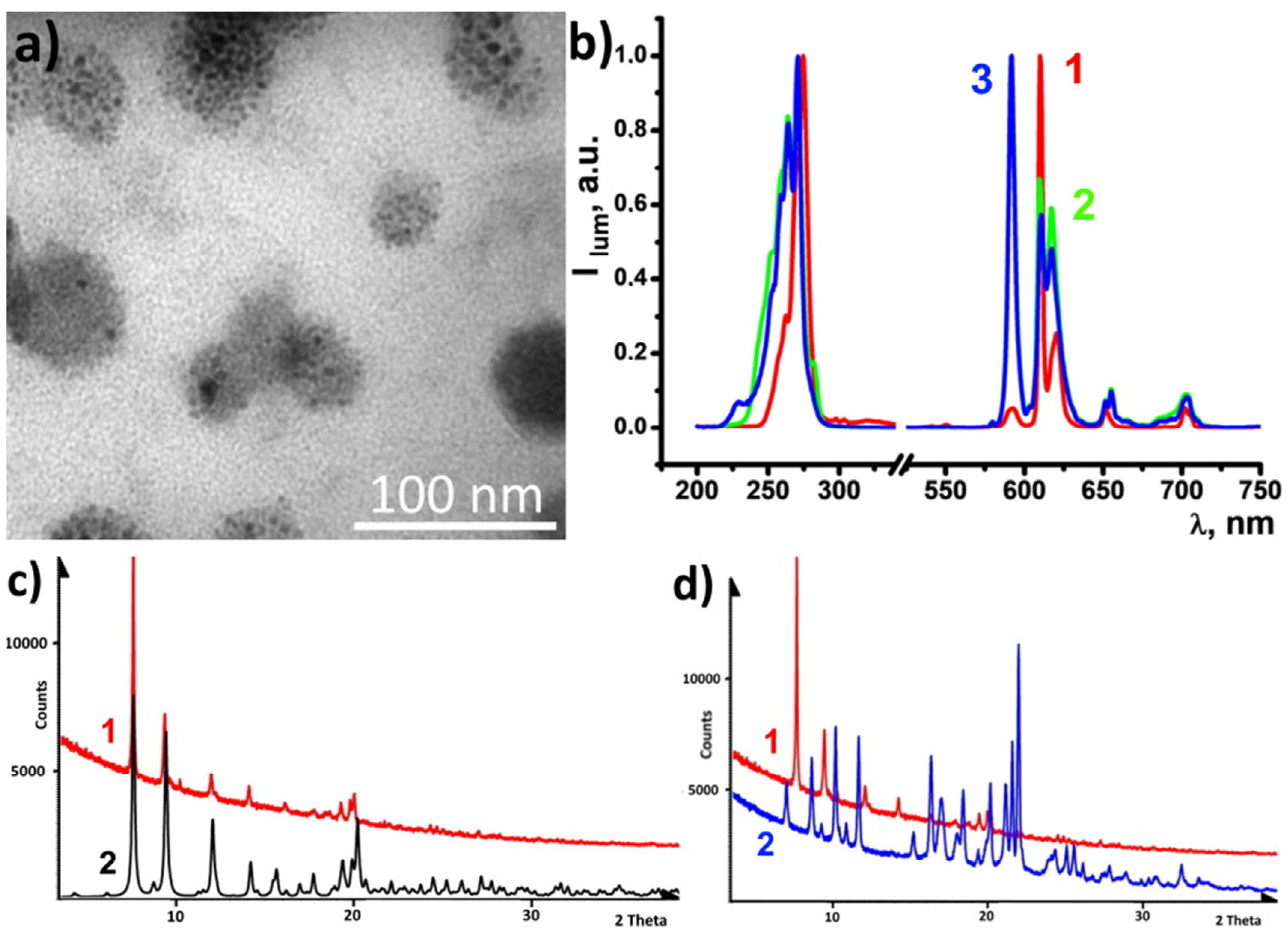
Figure 5. (a) TEM image of PSS-[Eu( a ) 3 ]. (b) Excitation and emission spectra of PSS-[Eu( L ) x ] (L = a , b , c , x = 3,2,1, respectively). (c) Simulated PXRD pattern out of single crystal data of [Eu( a ) 3 ] (2) in b , c , x = 3,2,1, respectively). ( c ) Simulated PXRD pattern out of single crystal data of [Eu( a ) 3 ] (2) in comparison to dried PSS-[Eu( a ) 3 ] PXRD pattern (1). (d) PXRD patterns of dried PSS-[Eu( a ) 3 ] (1) and comparison to dried PSS-[Eu( a ) 3 ] PXRD pattern (1). ( d ) PXRD patterns of dried PSS-[Eu( a ) 3 ] (1) and ligand a (2). ligand a